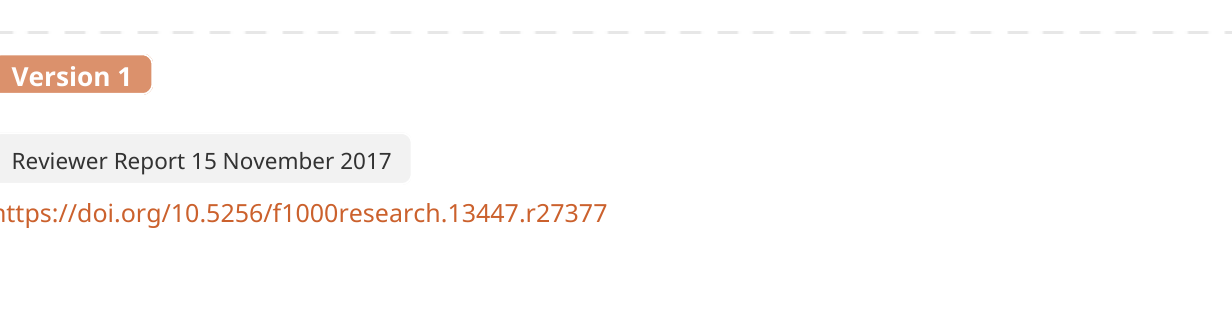
Fig. 3: Please indicate in the legend which muscles and WAT depots were